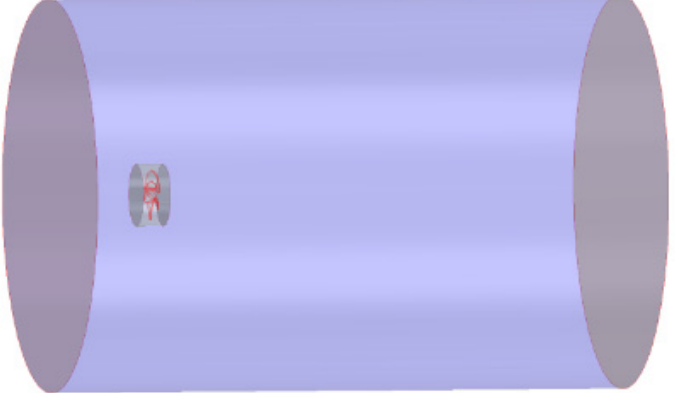
Figure 3. Calculation domain of propeller.